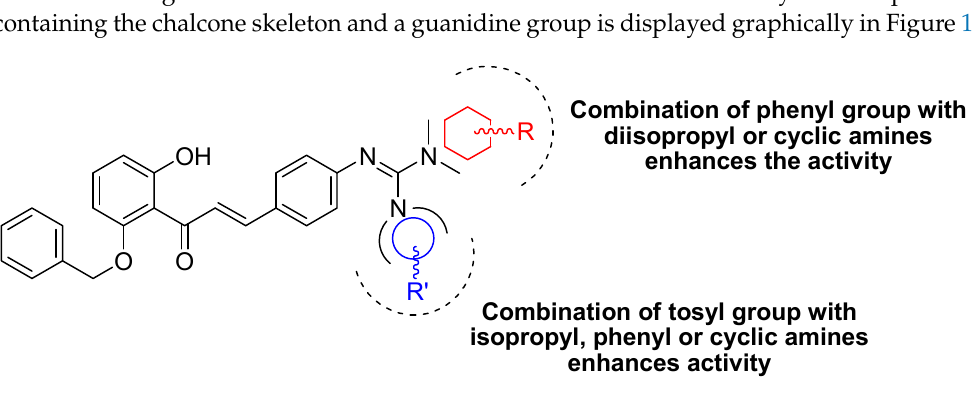
Figure 1. Structure–activity relationship of guanidines containing the 1,3-diphenylpropenone core against U-937 and HL-60 leukemic cells.